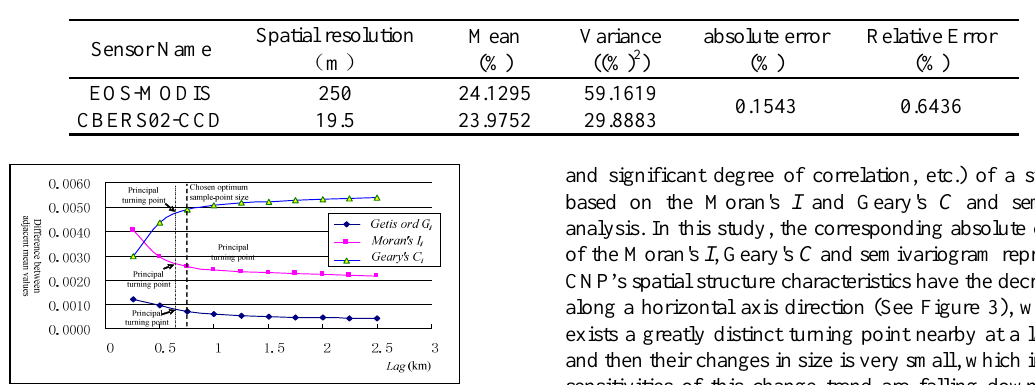
Table 1. Accuracy evaluation of mixed-pixel spectral decomposition of the CNP MODIS imagery